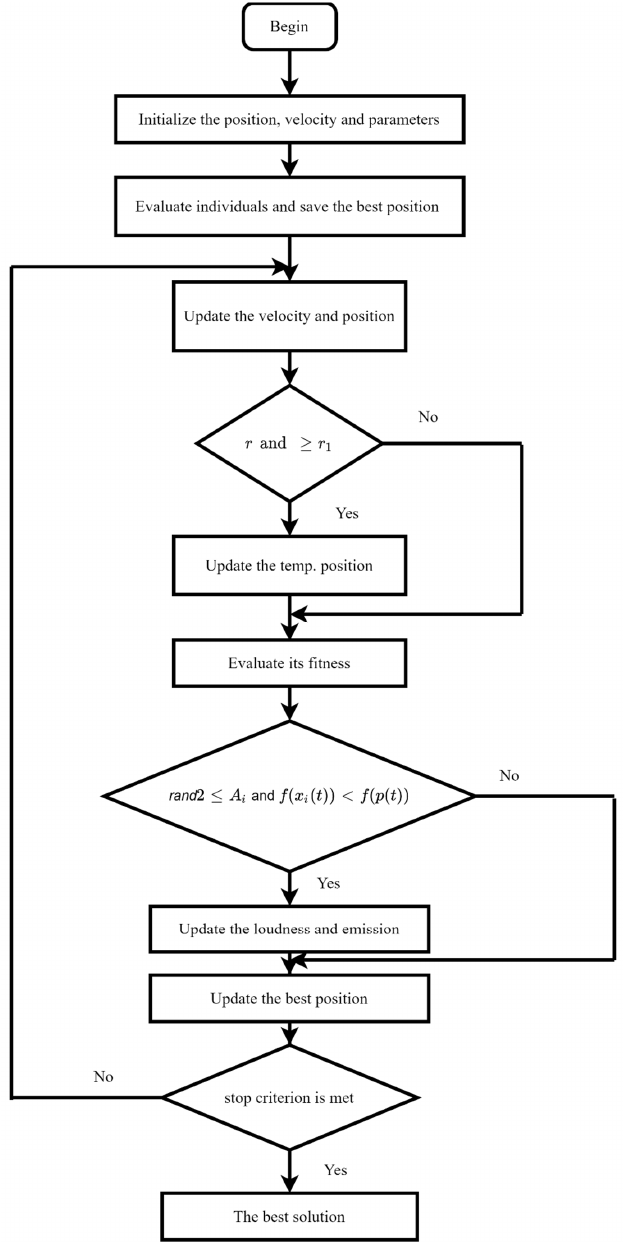
Figure 9. Framework of the Bat Algorithm.